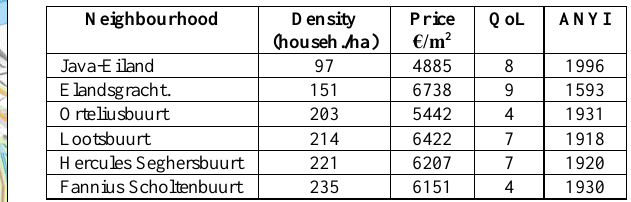
Table 2. Some characteristics of the 6 selected reference neighbourhoods.